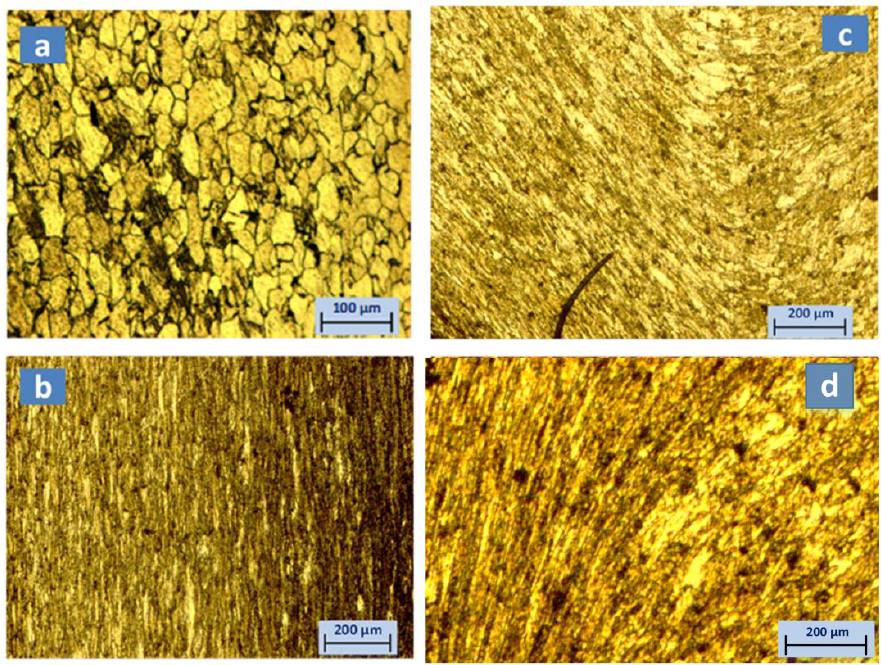
Figure 11. ( a ) Microstructure of the sample before deformation. ( b ) Microstructure of the body sample after flow forming with mandrel. Microstructure of the head sample after being deformed through two steps: ( c ) the fiber structure at position A and ( d ) the fiber structure at position B (shown in Supplementary Materials Figure S4).